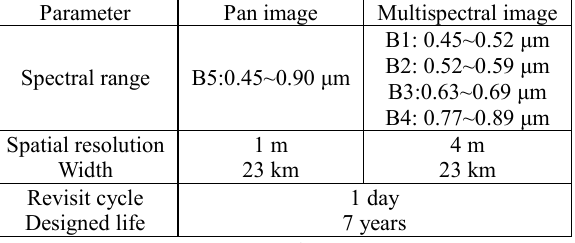
Table 1. Parameters of Beijing-2 satellite